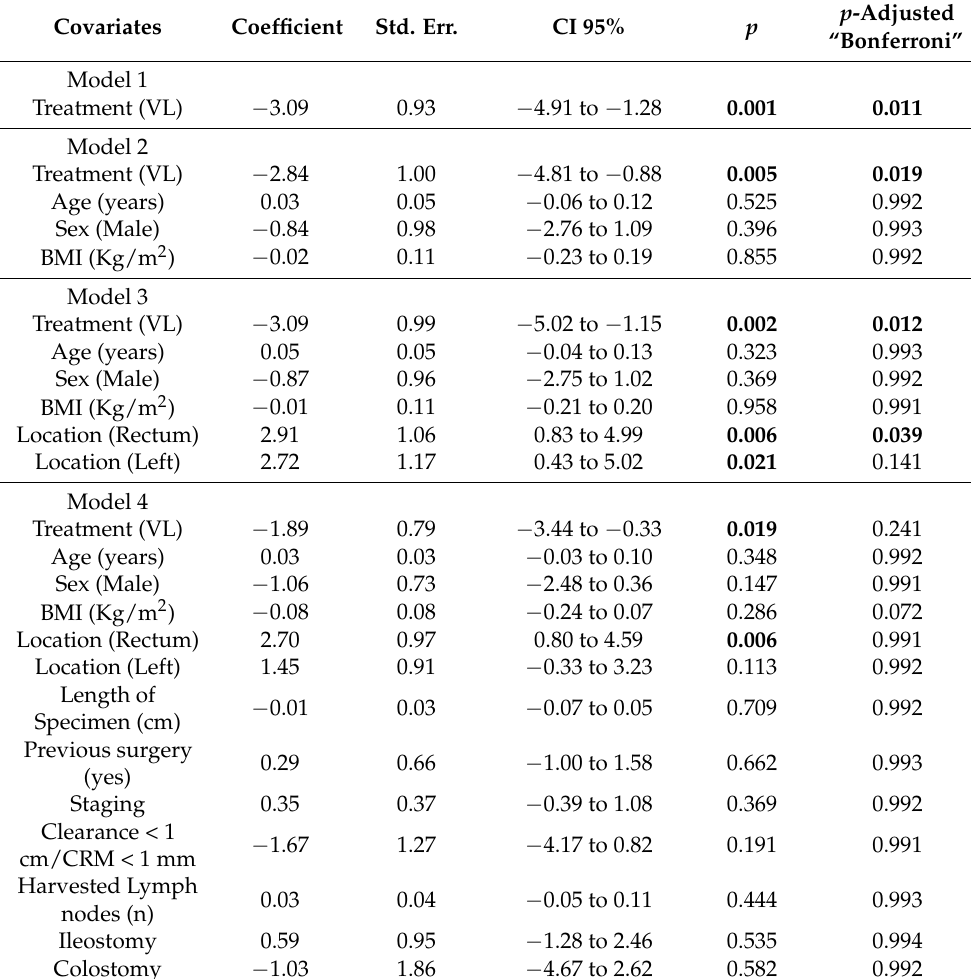
Table 3. Linear regression model for hospitalization (days).